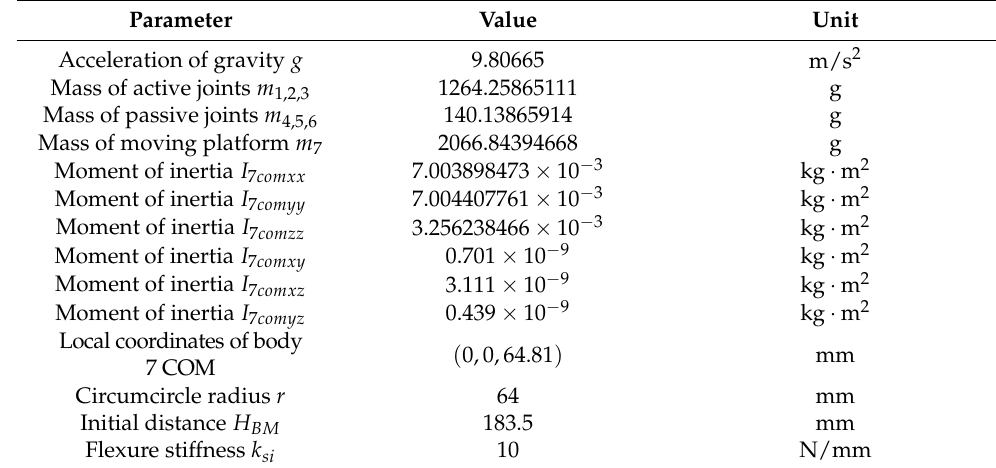
Table 1. Simulation parameters of the 3PPS PKM for dynamic model’s